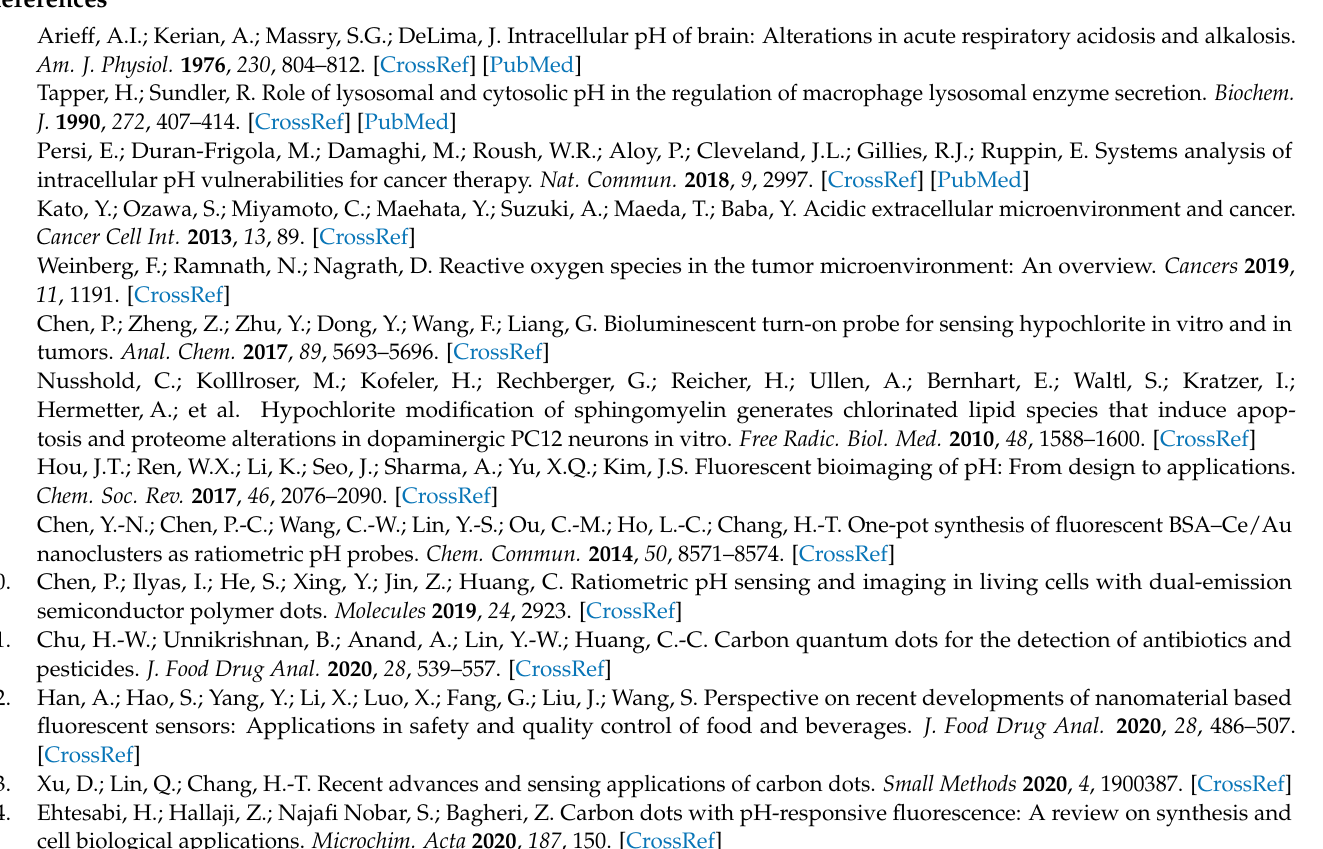
various pH, Figure S5: Flow cytometry analysis of Tramp C1 cells treated with mPA CNPs at various pH, Figure S6: Cell viability for Tramp C1 cells in the presence of mPA CNPs, Figure S7: FT-IR spectra of mPA CNPs in the absence and presence of NaClO, Figure S8: Flow cytometry analysis of Tramp C1 cells stained by mPA CNPs incubated with NaClO or NaClO/NAC, Table S1: Zeta potentials of mPA CNPs at various pH values, Table S2: Comparison of the in vitro fluorescence behavior of mPA CNPs with other CD-based pH sensors, Table S3: Comparison of the fluorescence behavior of mPA CNPs with other CD-based hypochlorite sensors, Table S4: One electron redox potential of ROS and